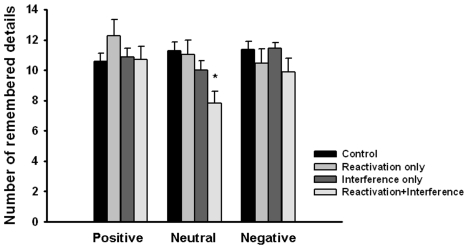
Number of details remembered of the positive, neutral and negative personal experiences on day 2.Neutral but not positive or negative autobiographical memories were reduced when participants learned new information after memory reactivation (* p<.01). Note that memories were about 2 weeks old when the memory test took place. Data represent means ± SEM.